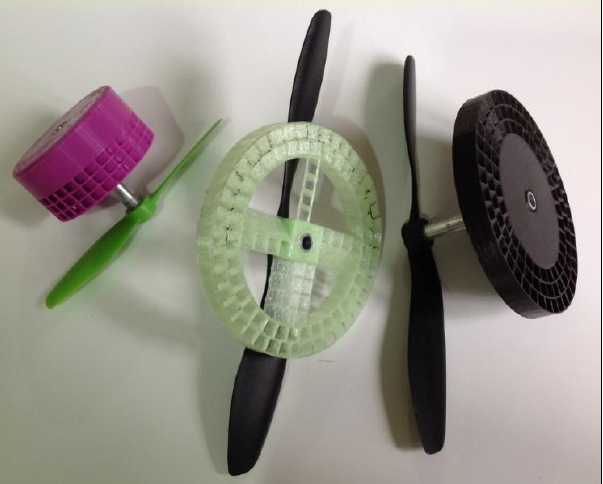
Figure 36. Samples of mesh turbines with propeller screws were prepared for demonstration